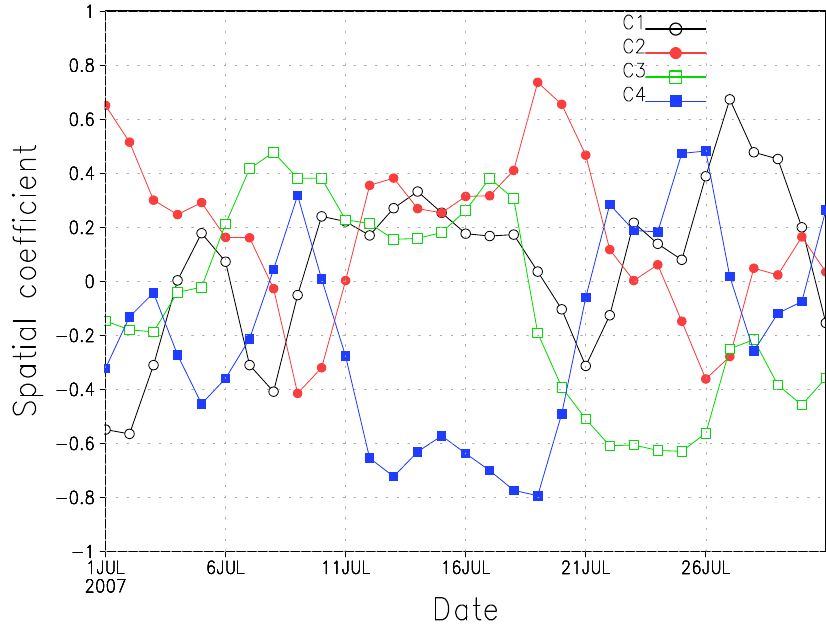
Figure 12. Same as Figure 7, except for the July 2007